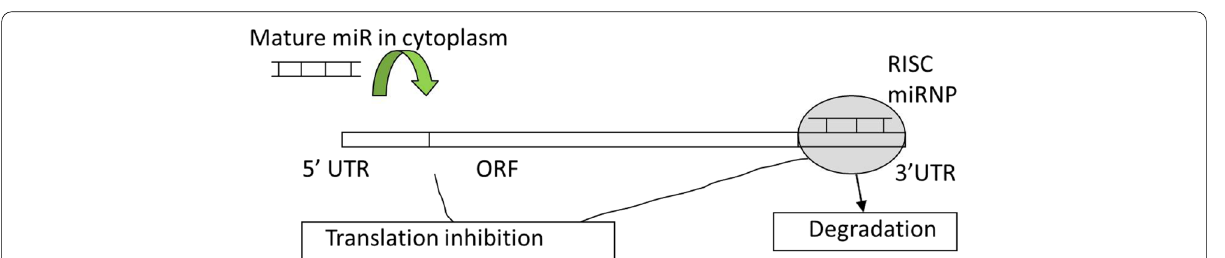
Fig. 2 Mode of action of miR. RISC makes reference to the RNA-induced silencing